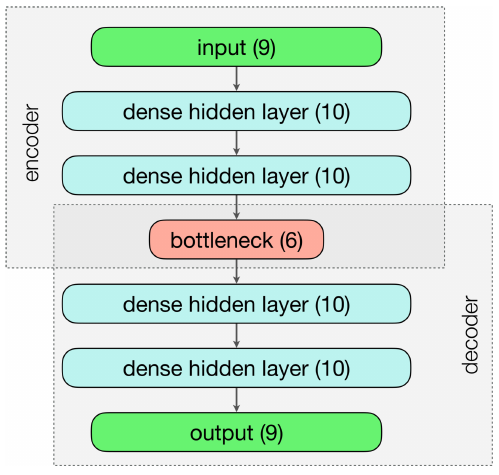
Figure 2. Neural Network